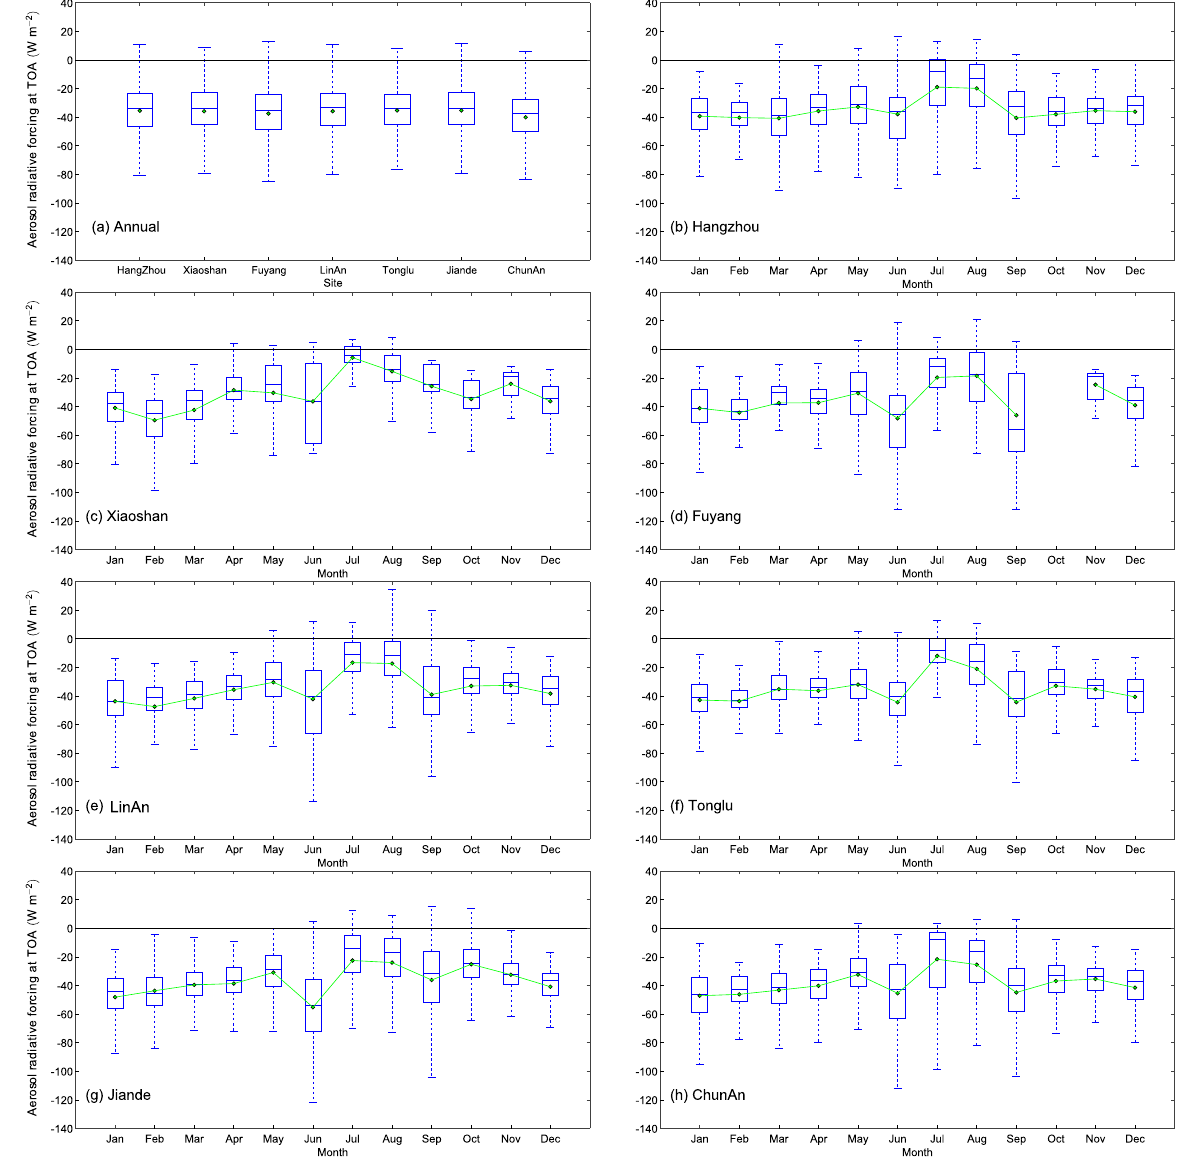
Figure 7. (a) Annual variations in the monthly mean direct aerosol radiative forcing (50–80 ◦ SZA) at the top of the atmosphere (TOA) at (b) Hangzhou, (c) Xiaoshan, (d) Fuyang, (e) LinAn, (f) Tonglu, (g) Jiande and (h) ChunAn. See Fig. 3 for an explanation of the symbols.